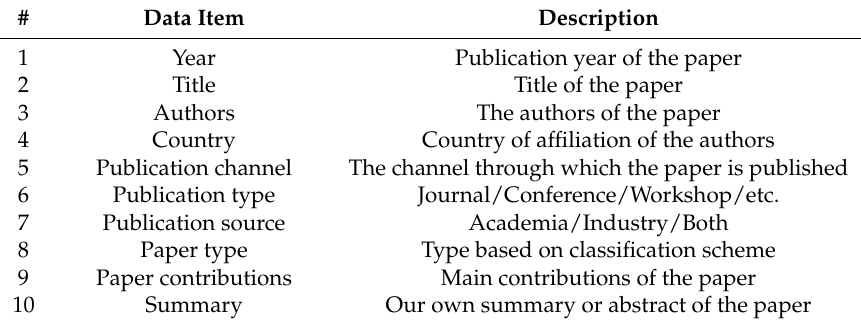
Table 2. Extracted data items